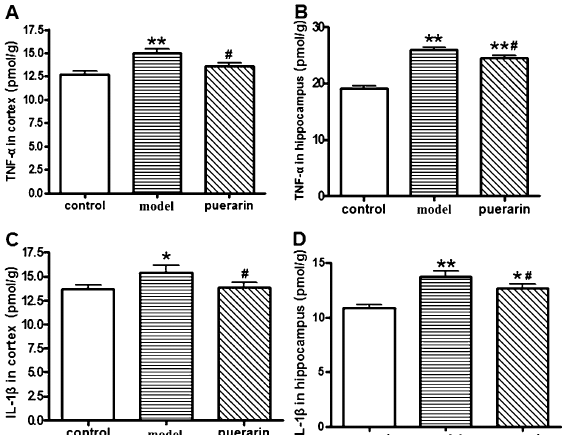
Figure 6. Detection of TNF- a and IL-1 b by ELISA. A , B , Content of TNF- a in the cortex and hippocampus. C , D , Content of IL-1 b in the cortex and hippocampus. *P , 0.05, **P , 0.01 vs control group; # P , 0.05 vs model group (one-way